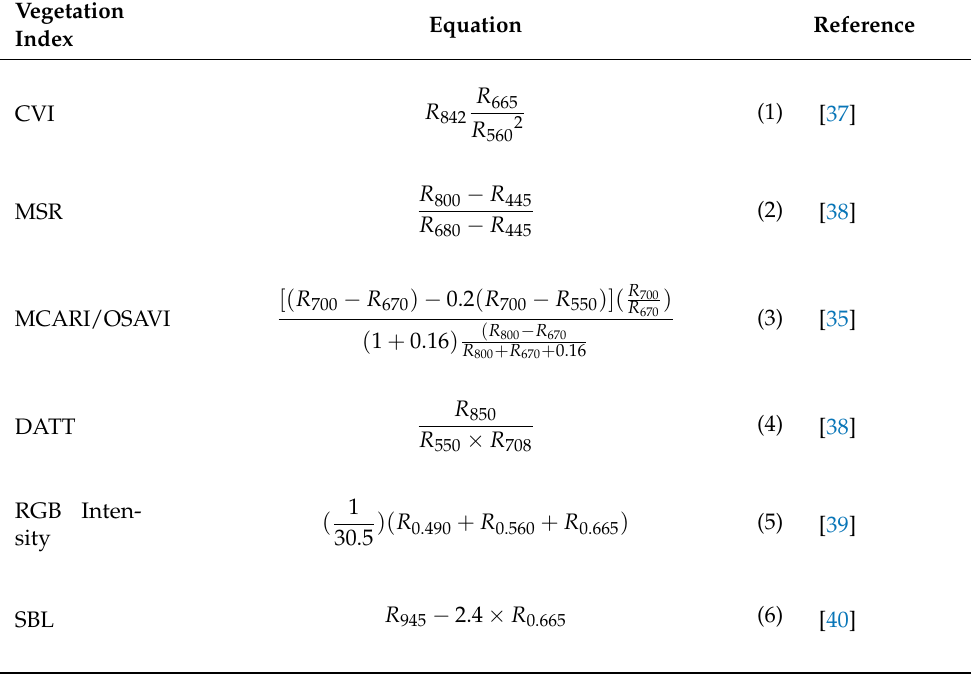
Table 2. Equations of the vegetation indices used in this study. R i = Reflectance in range i .